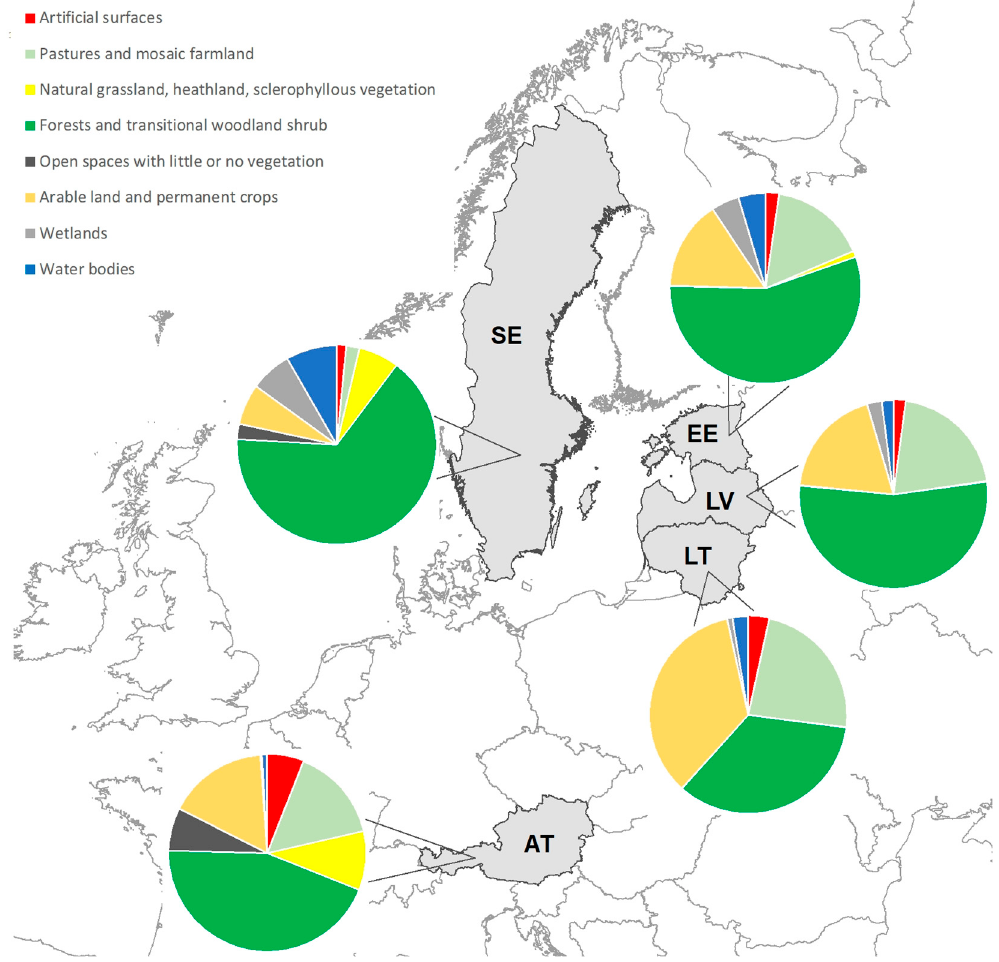
Figure 2. Land cover (land-use categories) according to EEA data (2018) in selected European countries (LV—Latvia, LT—Lithuania, EE—Estonia, AT—Austria, SE—Sweden) [49].